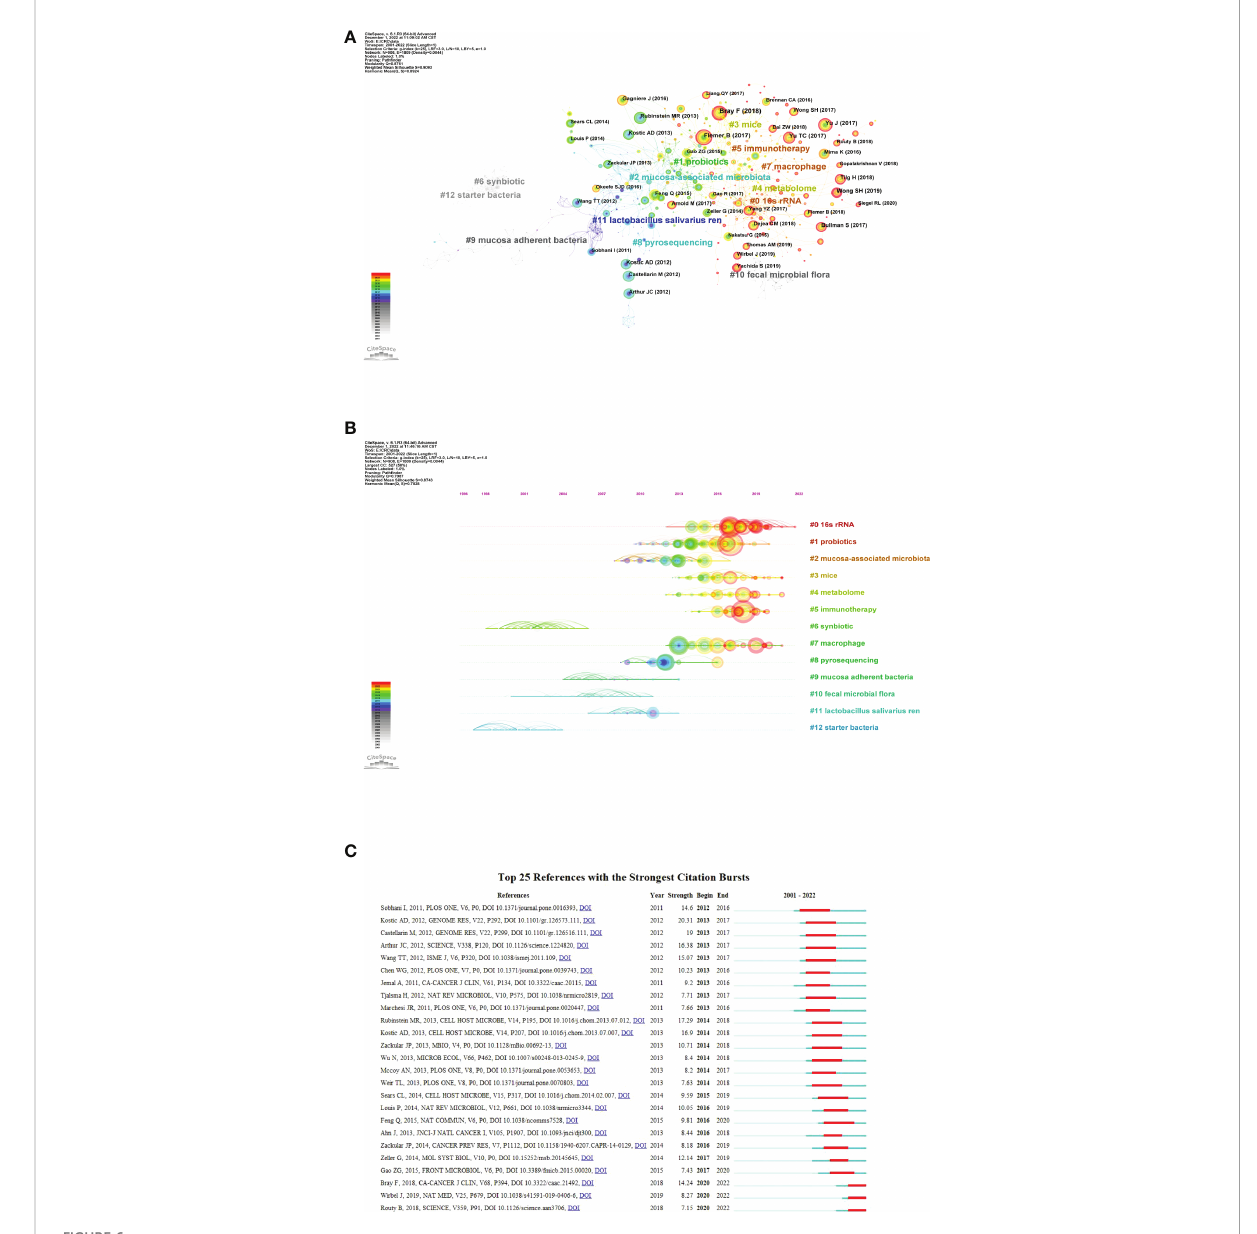
FIGURE 6 Reference co-citation analysis by CiteSpace. (A) Cluster view of reference co-citation (B) Timeline view of reference co-citation The clusters are placed vertically in descending order by size. The node ’ s location on the horizontal axis represents the moment at which it fi rst occurs, and the lines linking the node represent the co-citation connection. The amount of references determines the size of the node. (C) Top 25 references with the strongest citation bursts. The blue bar represents the timeline; The red bar represents the burst time period of the references, indicating the start year, end year, and duration of the